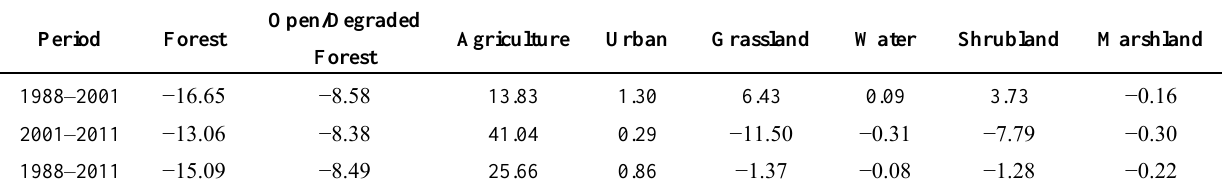
Table 6. Annual change rate of each class during various periods in the study area (positive = increase; negative = decrease; unit: kha per